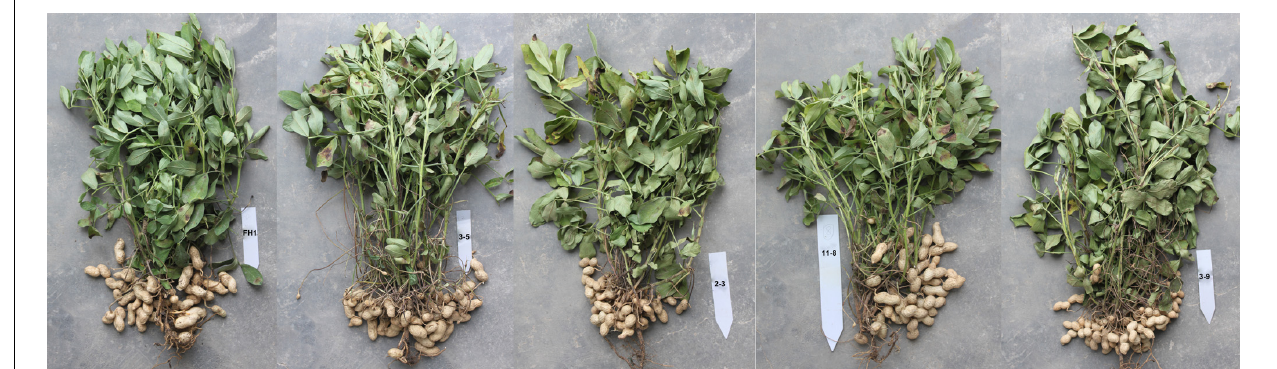
FIGURE 7 | Phenotype of transgenic peanut and its untransformed control at the harvest